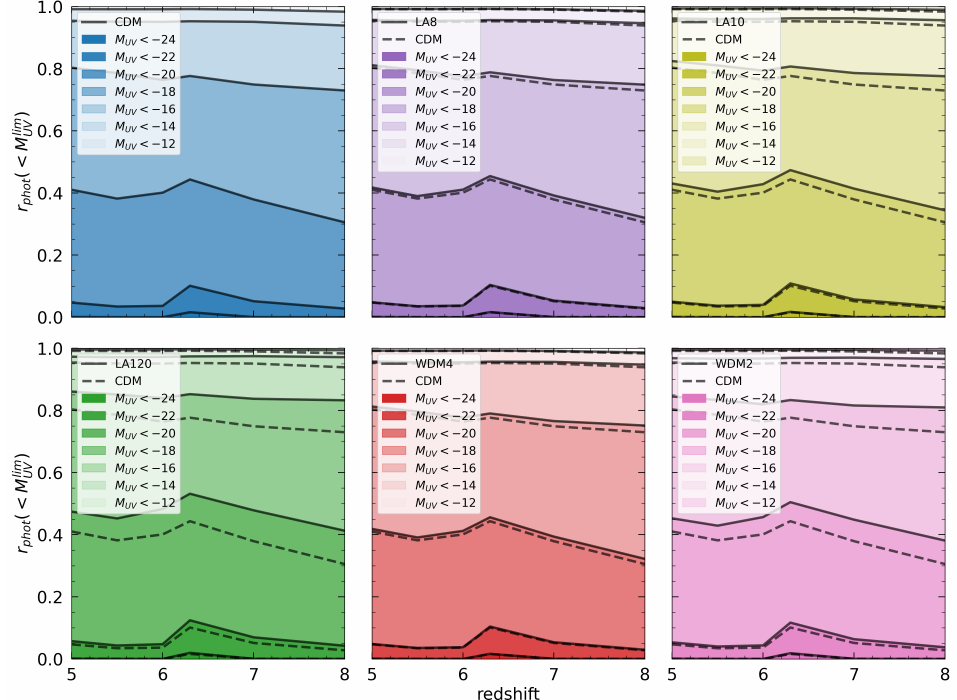
) , where ˙ N ion , tot is lim = − 12 and M inf = − 25. We compare UV UV